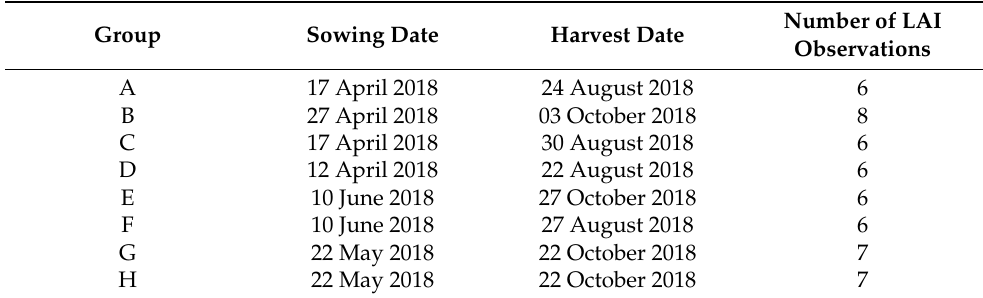
Table 3. List of groups of fields. Each group has the same sowing date, harvest date and number of available LAI observations.